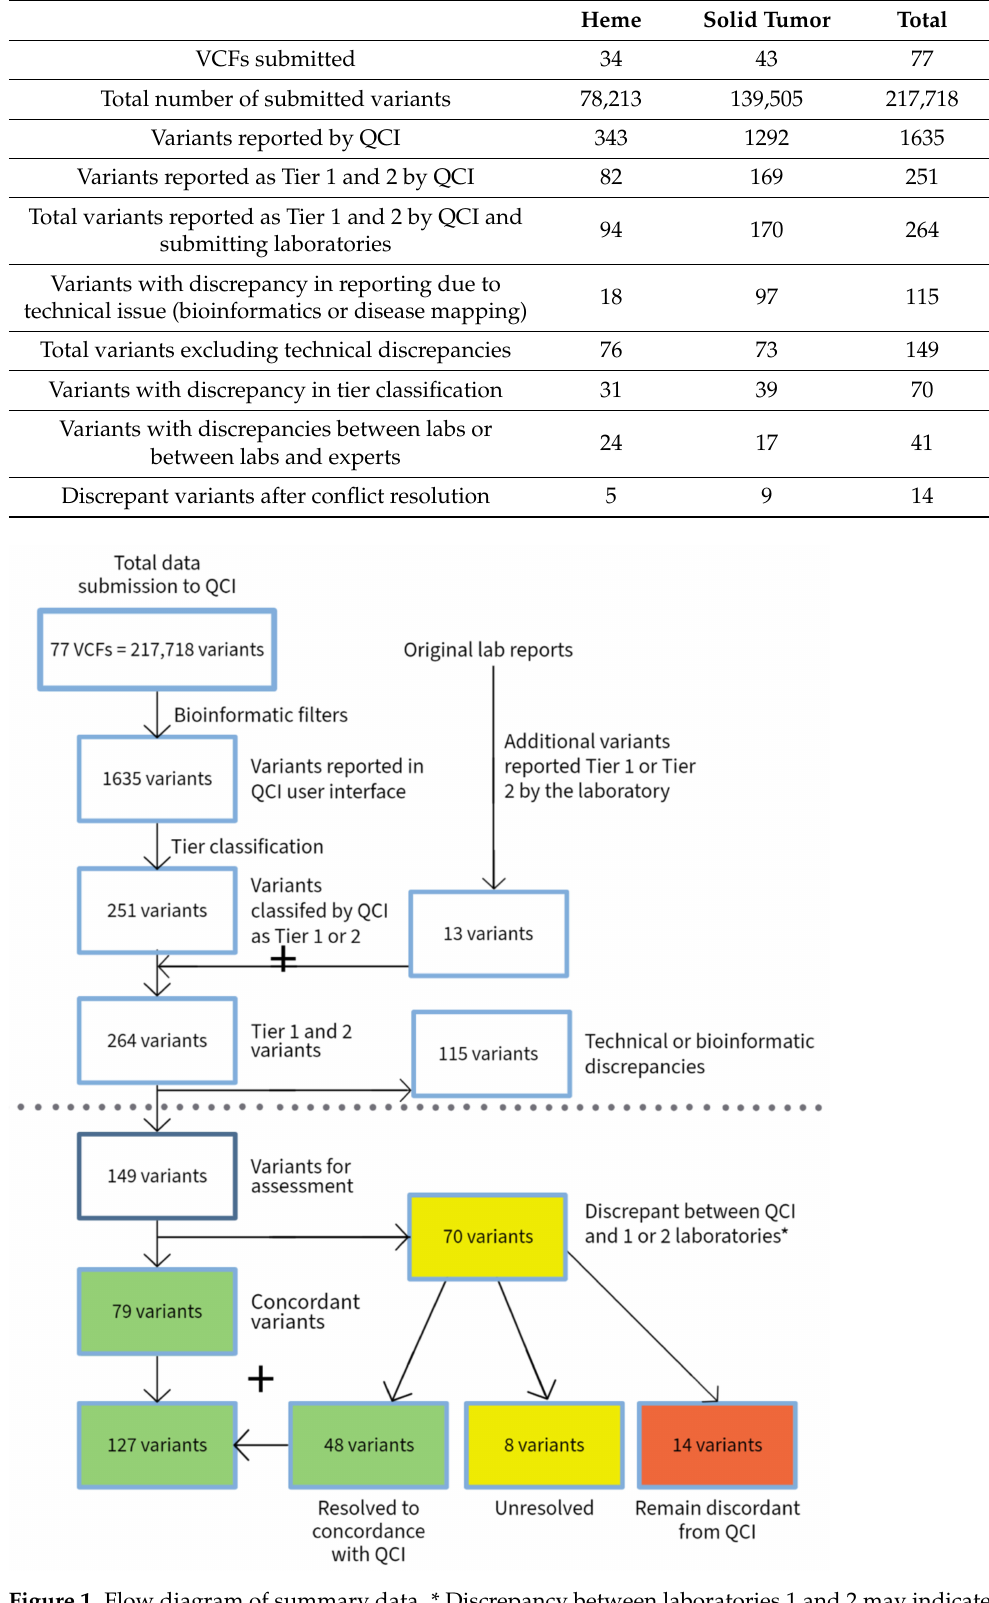
Table 1. Summary data.